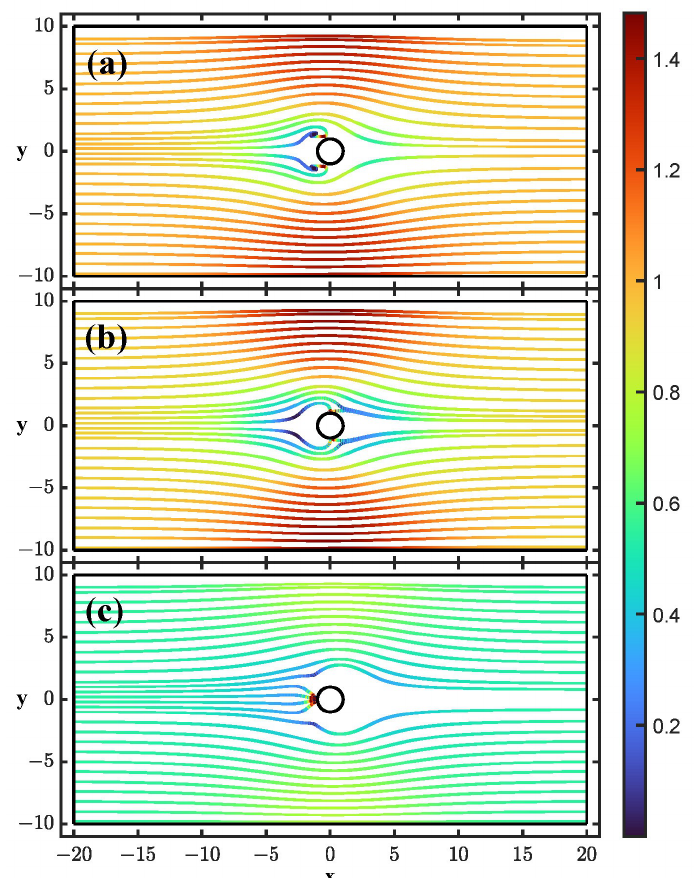
Figure 3. Particle trajectories for an applied electric field perpendicular to flow direction: ( a ) low frequency and Λ = 1; ( b ) low frequency and Λ = 0.5; ( c ) high frequency. The colors represent the magnitude of the particle velocity in units of v 0 .